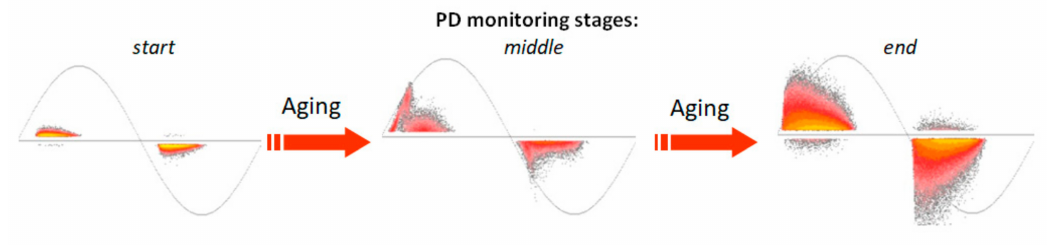
Figure 6. Representative PD images of distinctive classes in the long-term monitoring of the aging of electrical insulation.